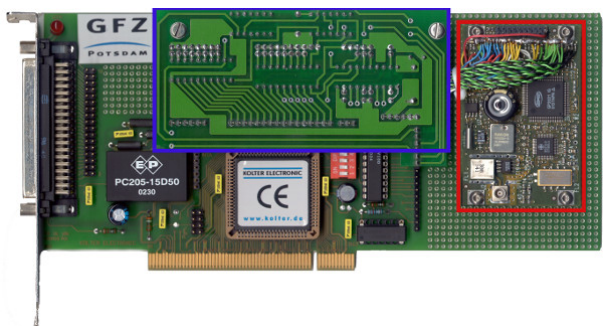
Figure A1. GFZ’s OpenGPS receiver board for PCI interface